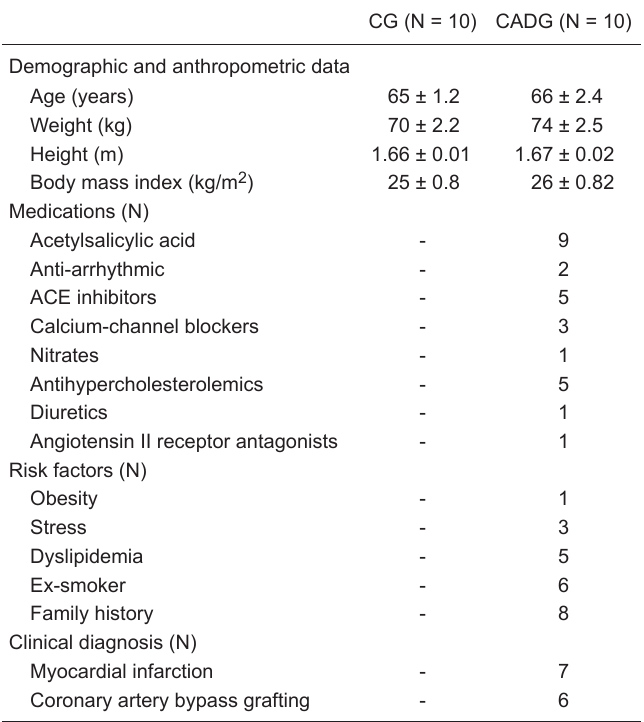
Table 1. Demographic and anthropometric data, medications, risk fac- tors, and clinical diagnosis of the control group (CG) and the coronary artery disease group